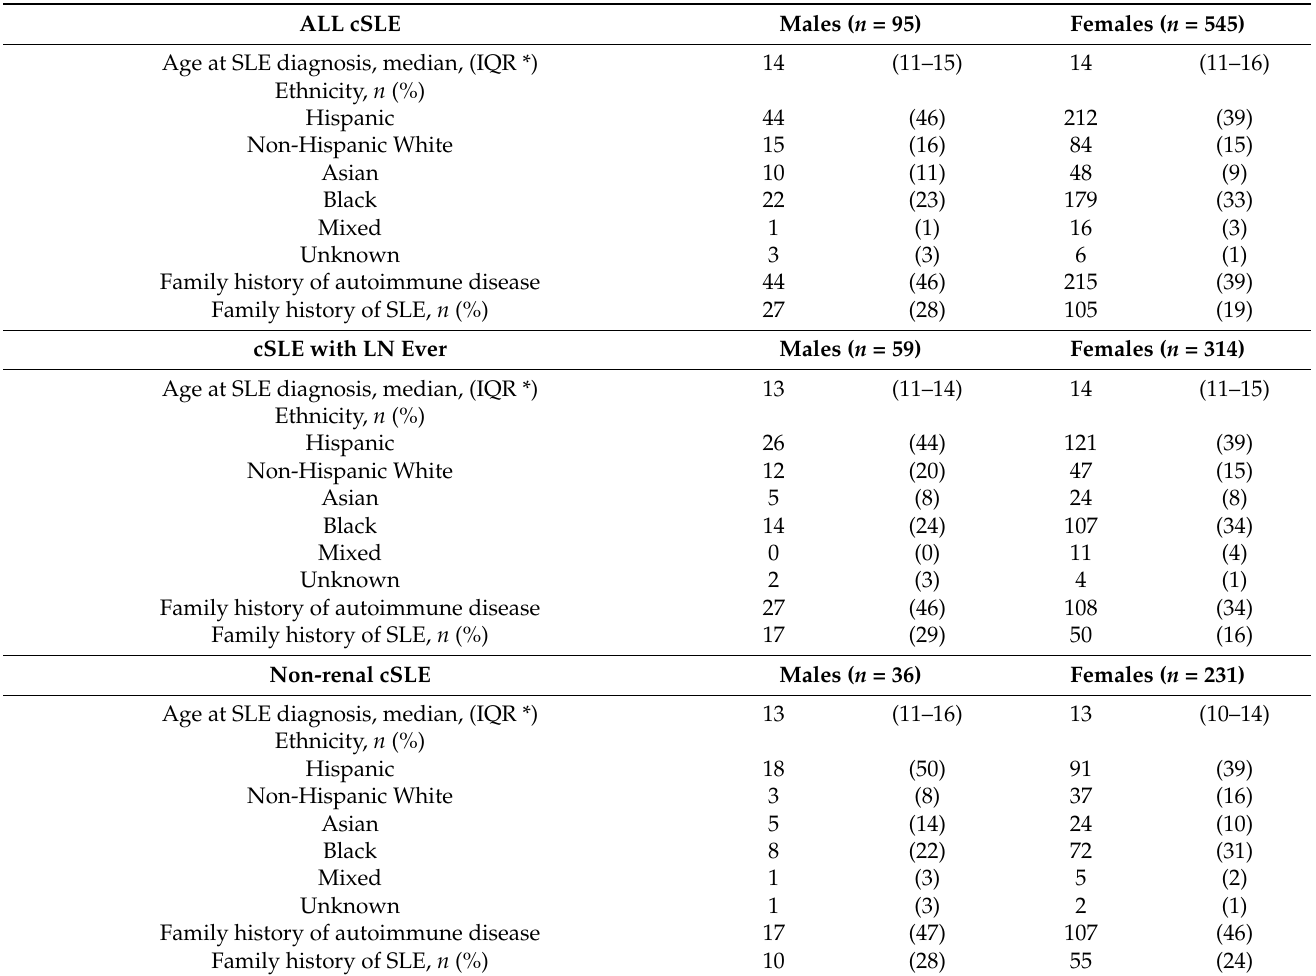
Table 1. Demographics and clinical history of 95 males and 545 females with childhood-onset SLE, with and without kidney